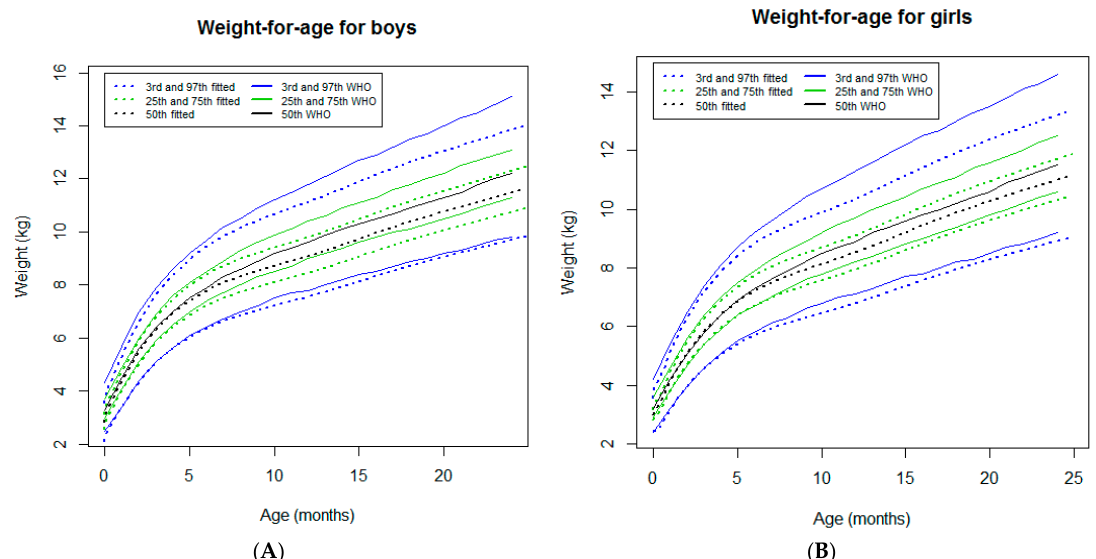
Figure 2. Comparison of the WHO Child Growth Standards (solid lines) with smoothed centile curves (dotted lines) of measured weight-for-age for boys ( A ) and girls ( B ) from the neonatal period to 24 months of age.